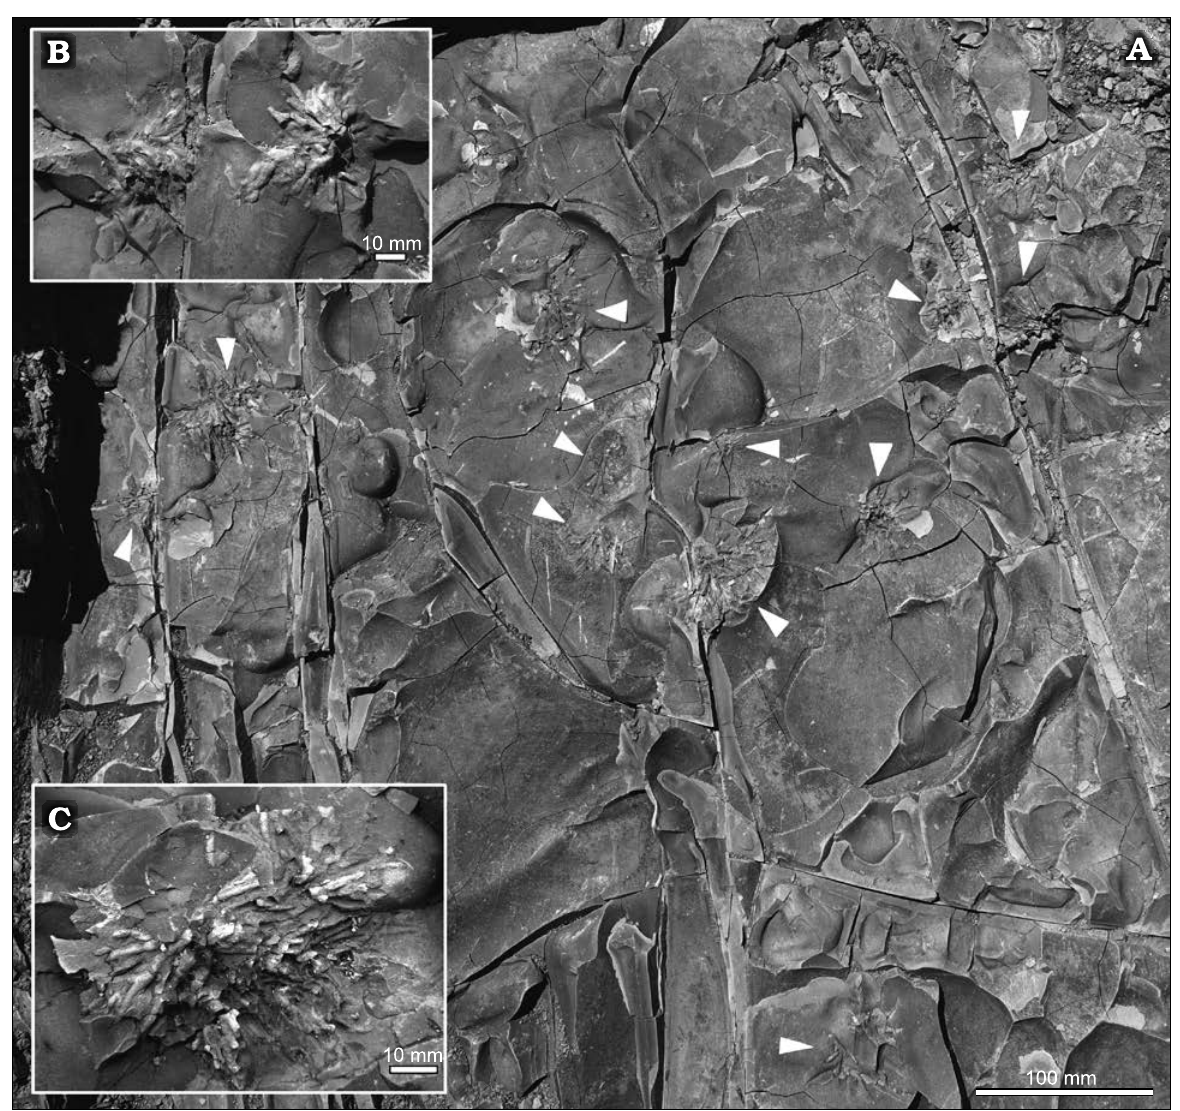
Fig. 6. Radial to rosette structures ? Dactyloidites isp., from Velká nad Veličkou, Czech Republic, Eocene. A – C . Field photos of in situ specimen (indicated by arrows, A ), close ups ( B , C